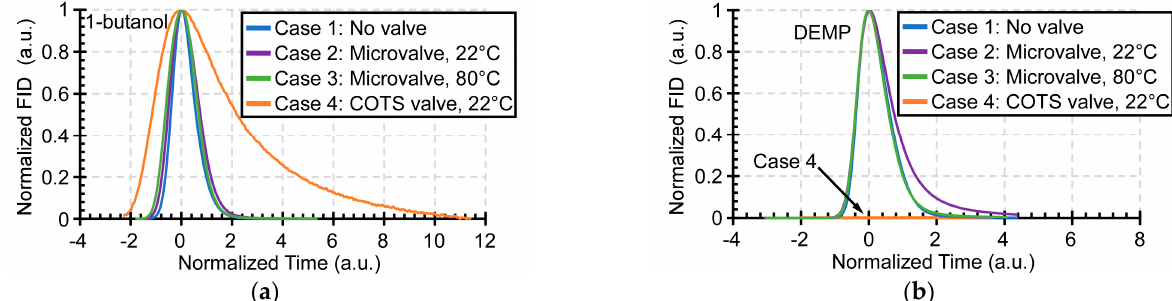
Figure 13. ( a ) Normalized and shifted peaks for 1-butanol. ( b ) Normalized and shifted peaks for diethyl methyl phosphonate.